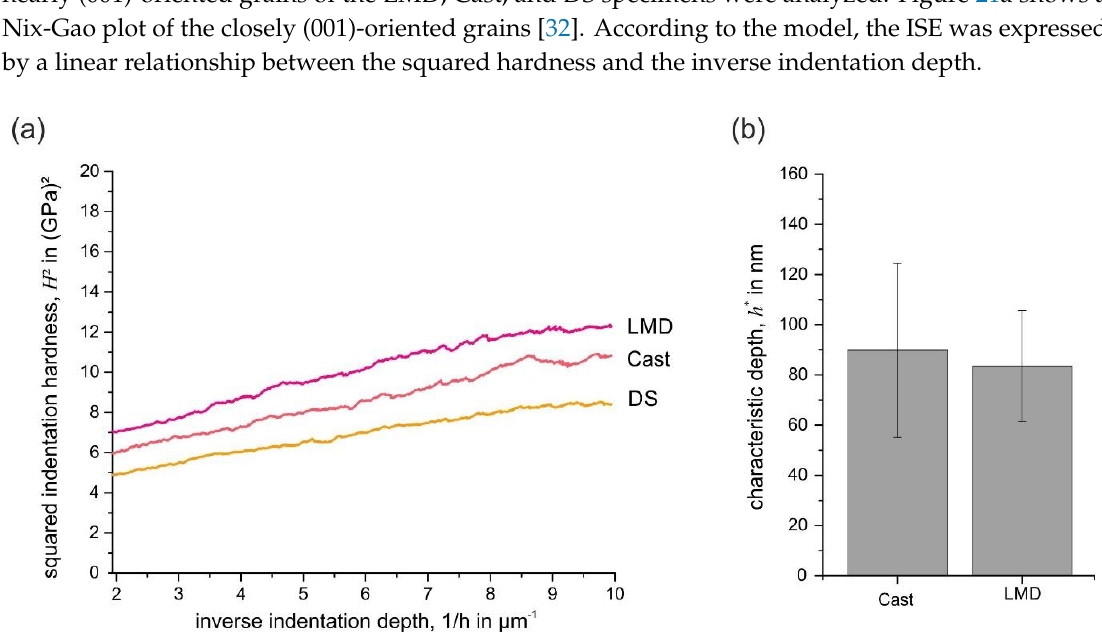
Figure 20. Normalized pile-up parameter and top-view AFM image of the Cast and LMD specimens.